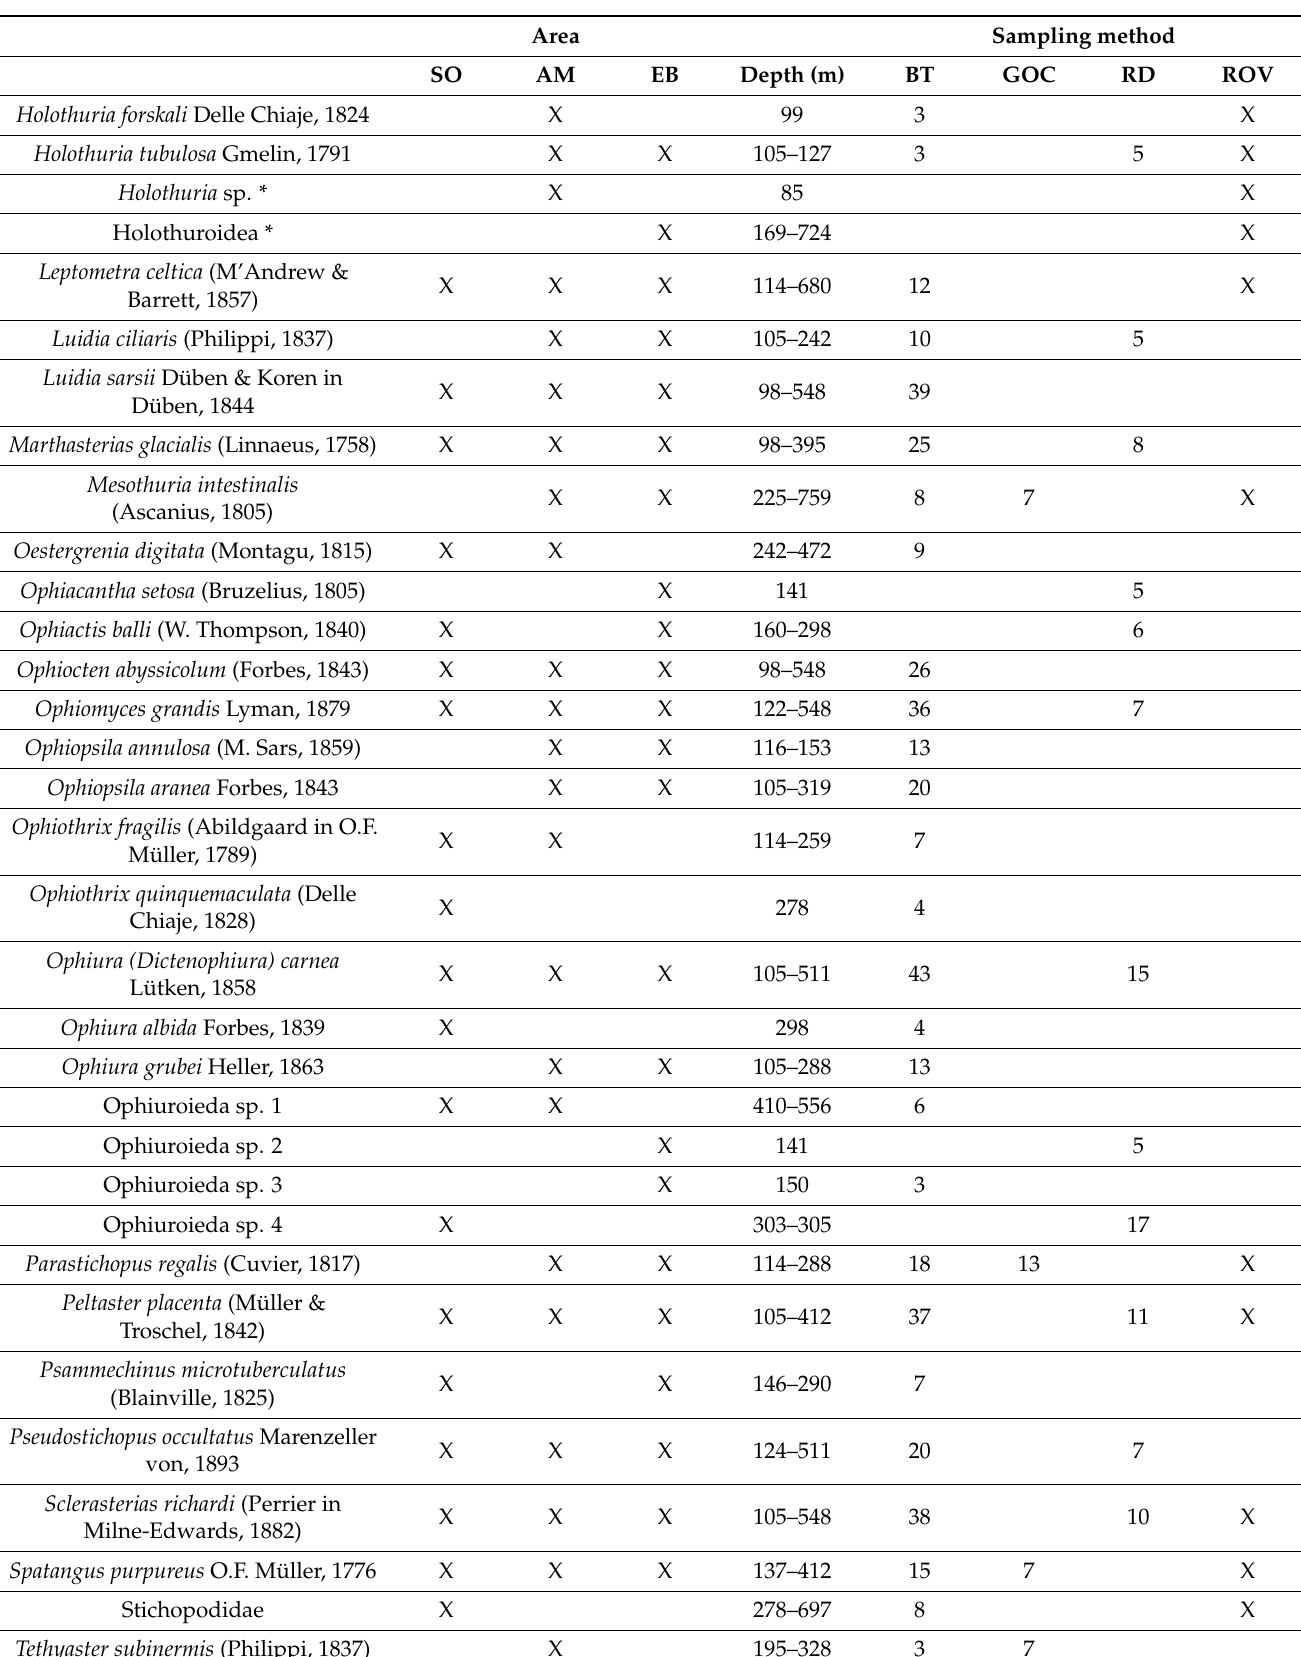
Table A7. Cont. Area Sampling